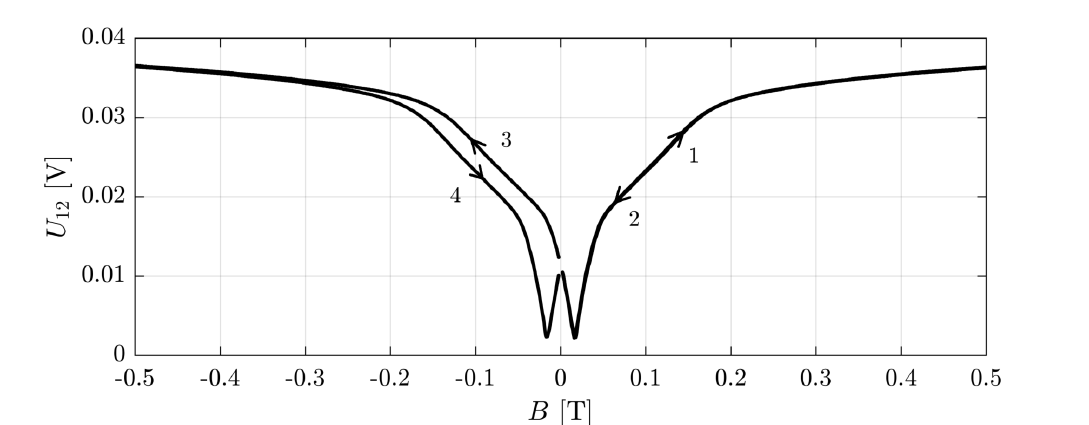
Figure 3. A voltage drop U 12 between two adjacent contacts (1 and 2) registered at the current of 1 µ A supplied to the other pair of contacts (3 and 4). The horizontal scale shows the current flowing